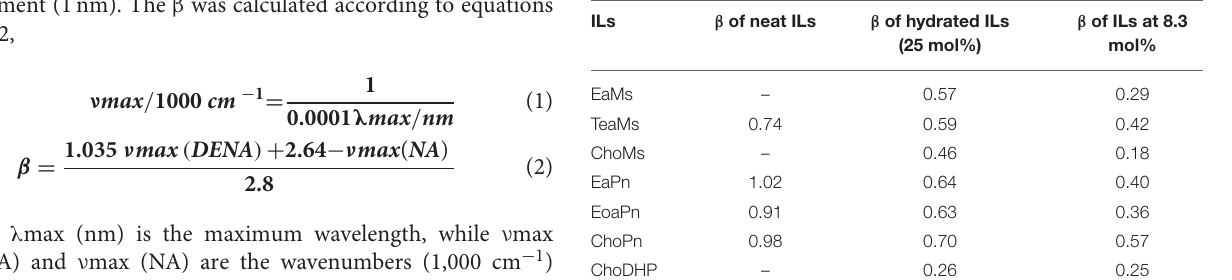
TABLE 1 | β values of ILs and IL-water mixtures in this